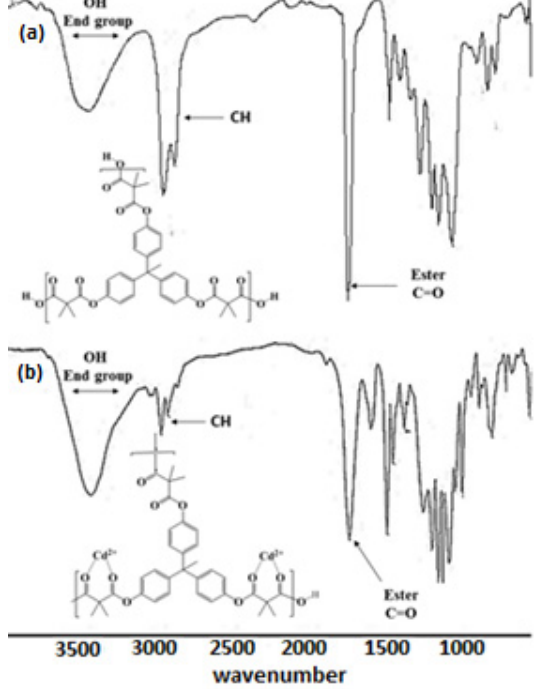
Figure 2. FTIR spectra of ( a ) the hyperbranched polyester and ( b ) the hyperbranched polyester–Cd (II).